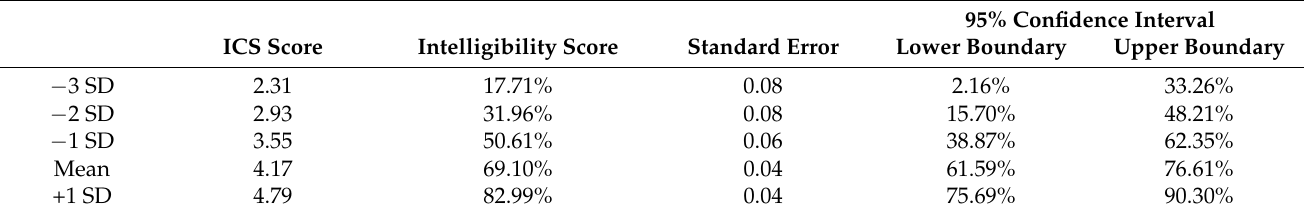
Table 2. Predicted transcription intelligibility scores based on marginal ICS composite score